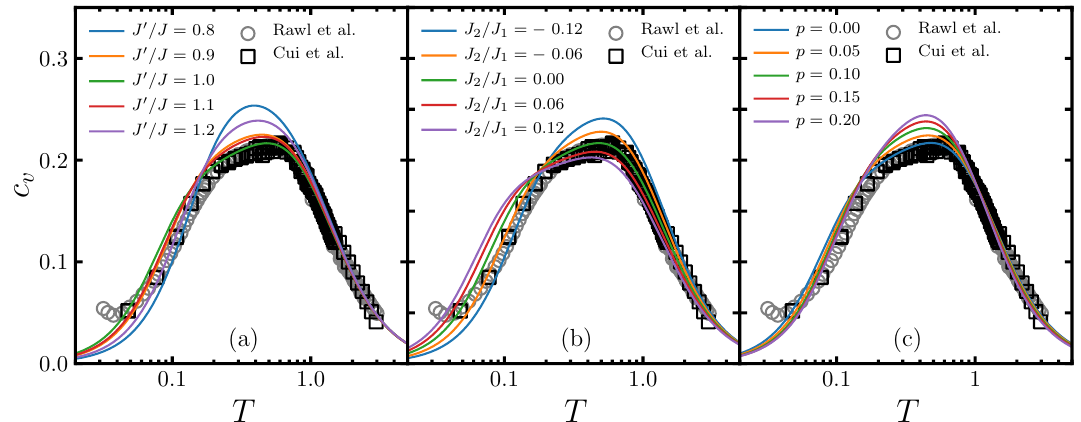
Figure 7: Specific heat c for α = 2 in several cases: (a) with spatial anisotropy, v (b) with next-nearest neighbor interactions, and (c) with impurities. Experimental results are denoted by circles [ 37 ] and squares [ 38 ]